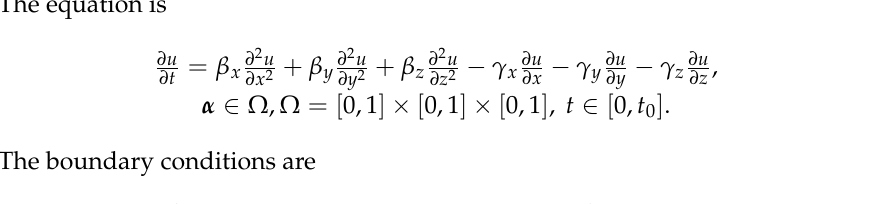
Figure 8. Calculation results on layers z = k /10, ( k = 0,1, · · · ,10 ) given by the HIM method. 4.3. An Advection–Diffusion Equation with Dirichlet Boundary Conditions The equation is